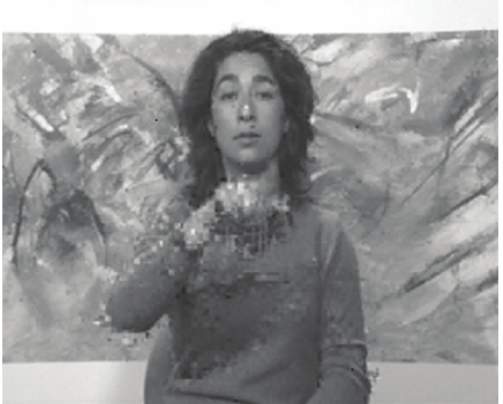
Figure 5: Example of block distortion on fractal interpolated frame.